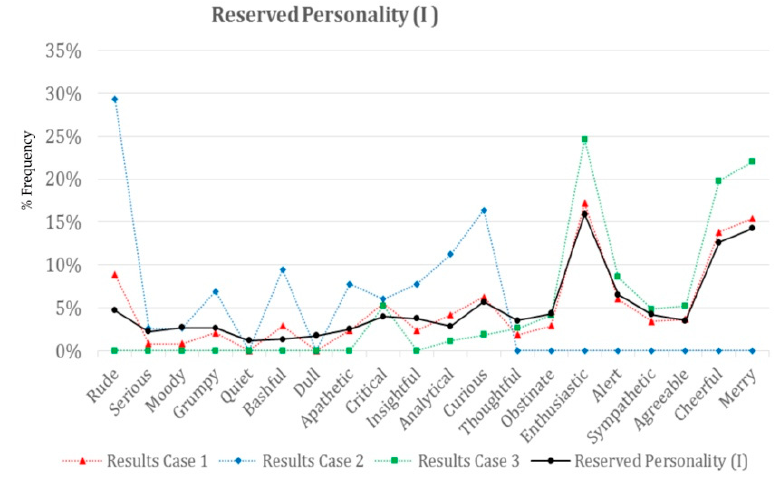
Figure 14. Comparison of cases for a Reserved Personality.